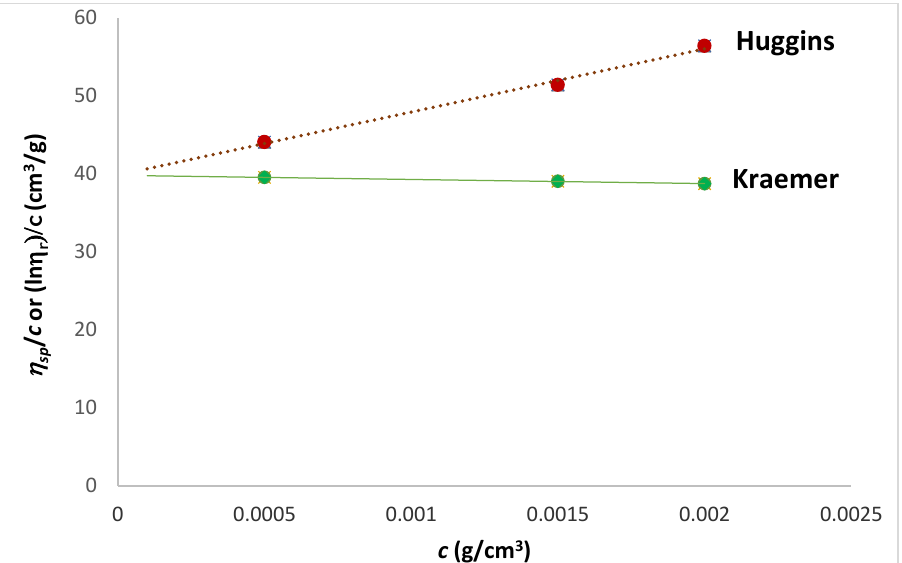
Figure 3. Huggins and Kraemer’s plots. Huggins is η sp / c vs. c , and Kraemer is (ln η r )/ c .